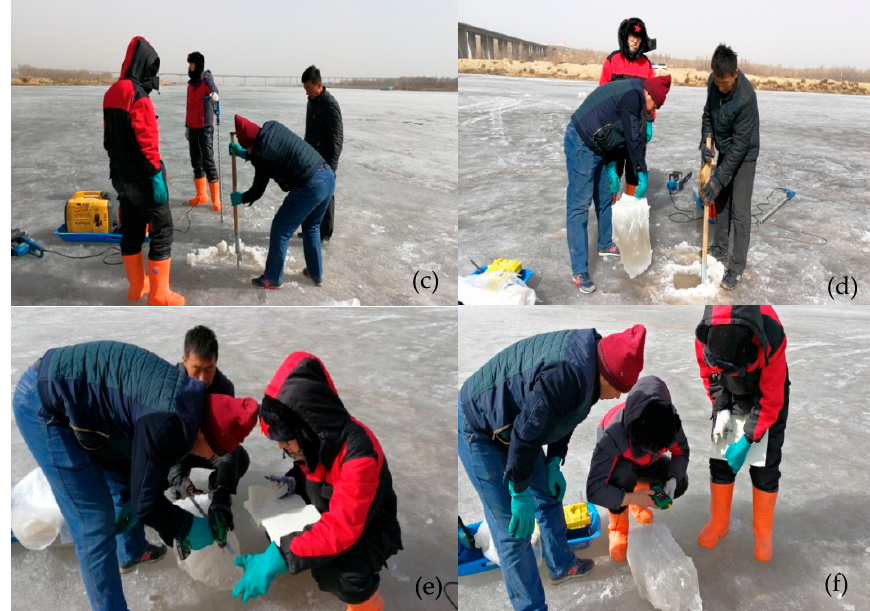
Figure 1. The whole process of ice sample collection: ( a ) cutting with an electric saw; ( b ) drilling ice; ( c ) cutting with a plate saw; ( d ) ice sample; ( e ) ice thickness measurement; ( f ) temperature measurement in ice.